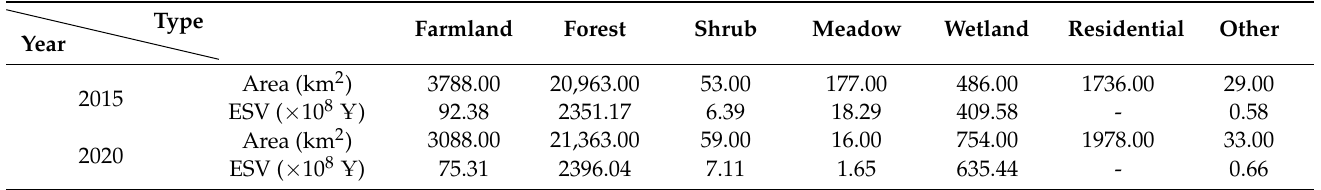
Table 7. The Area and ESV of Major Land Cover Types in the SAHMHER.